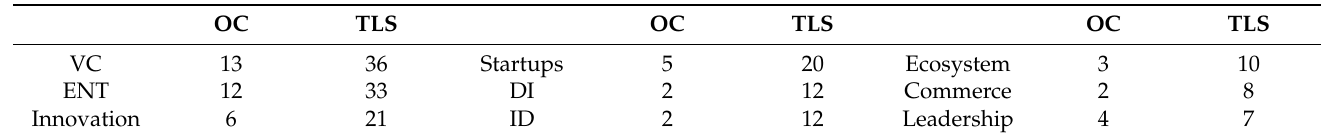
Table 10. Unicorns: Co-occurrences and total link strength of business-related selected keywords (SCOPUS database).